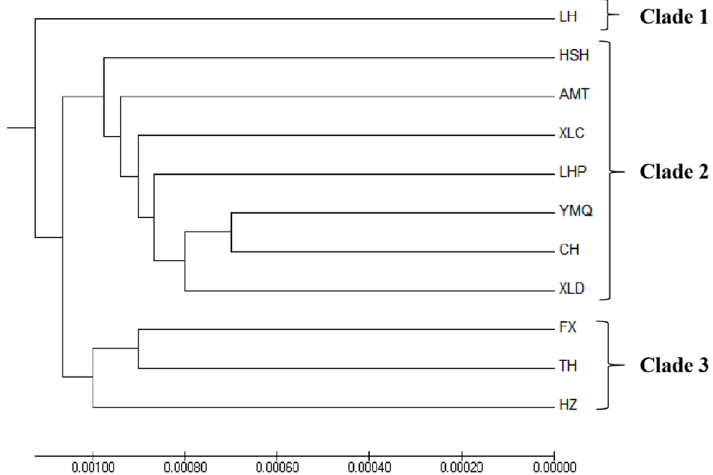
Note: Asterisks * indicate significant values after Bonferroni correction. * (0.01 < p < 0.05), ** ( p < 0.01).